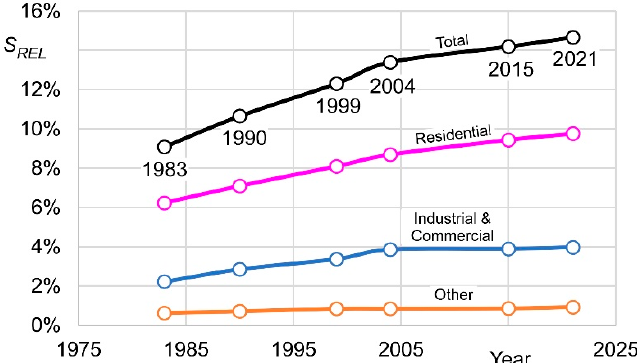
Figure 3. Relative footprint surface ( S REL ) through the years for the different categories of buildings in the study area.